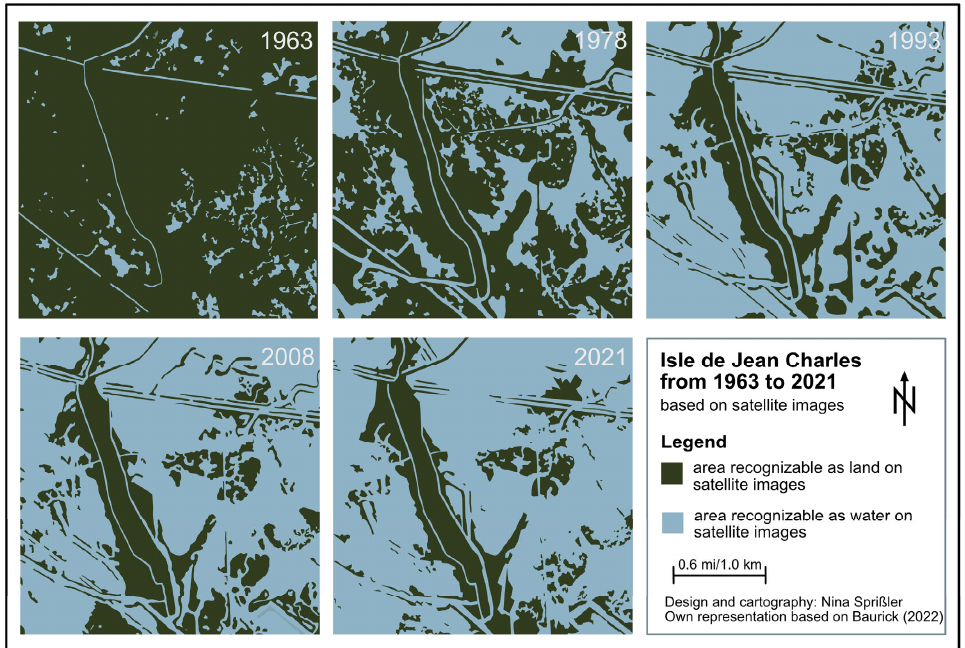
Figure 4. The change of the physical Space 1 due to land loss is particularly evident in the example of Isle de Jean Charles: The area recognizable here as land decreases significantly between 1963—the area identifiable as land dominates—and 2021—the area identifiable as land has decreased significantly, water dominates. This results in an area that is characterized by an everchanging hybridity of water and land, as Sallenger [66] (p 6) puts it, “a coast in motion”. It is important to note that the present cartographic representation of land loss was created on the basis of satellite imagery, classifying as land what is visually recognizable as such (own representation based on [67]). However, relocation of affected communities is not only accompanied by spatial change but usually also by the loss of lifestyles that have been practiced for generations because residents “strongly identify with place, and this attachment and identification has developed from generations where their ‘livelihood,’ that is, everything from the social to the economic, has been intertwined with place.” [68] (p 348). This close interweaving of space and daily life has led, not least, to the emergence of “localized expert knowledge”, as Burley et al. [69] (p 362) make clear. These local knowledge stocks in the c-mode contain important information and possibilities for action for the restoration of the coastal areas, but, according to the study conducted by Burley et al. [69], they receive little attention in the eyes of those affected when implementing and planning coastal protection measures (see also [68,70]). Lambert et al. [59] further point to the potential that the importance of space has for cultural and traditional aspects throughout Louisiana: Beyond the liveli- hoods of affected coastal regions, land loss affects “important cultural symbols and tradi- tions, particularly related to Louisiana’s renowned cuisine” [59] (p 13).